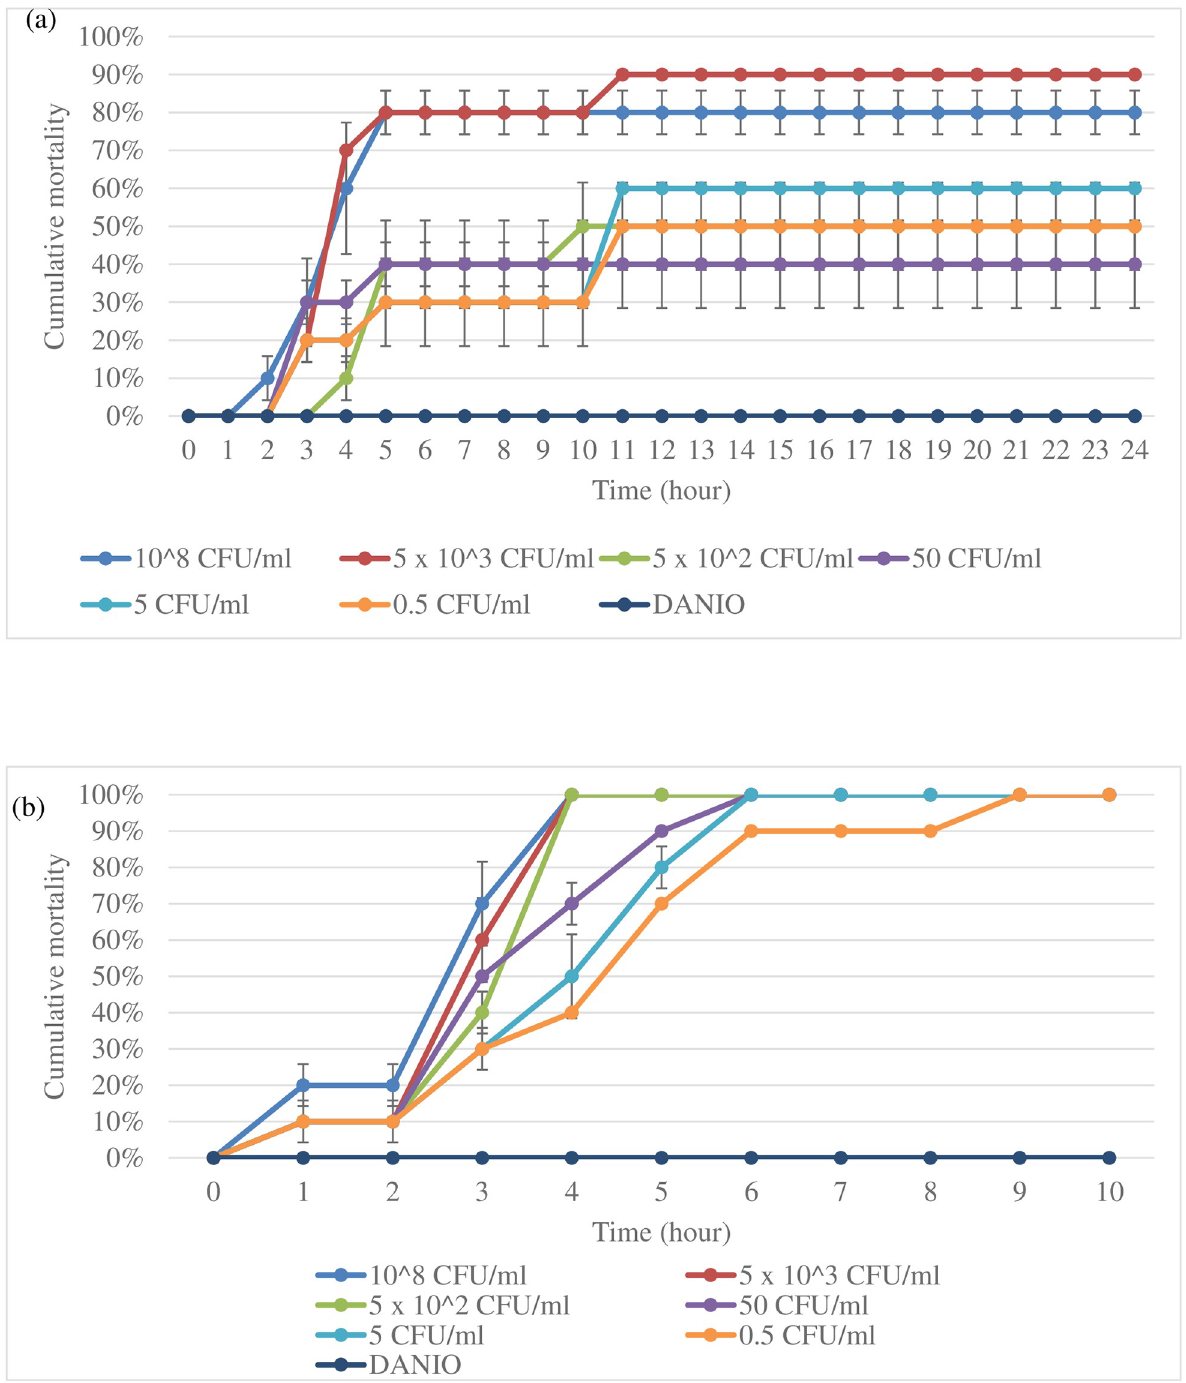
Fig 9. Survivability of zebrafish larvae based on morphological appearance. (a.) zebrafish larvae were able to survive up to 24 h when infected with K . pneumoniae 2146 for 30 min. while (b.) upon increasing the infection to 90 min the zebrafish larvae was able to survive up to 9 h. The experiment was done in triplicates.